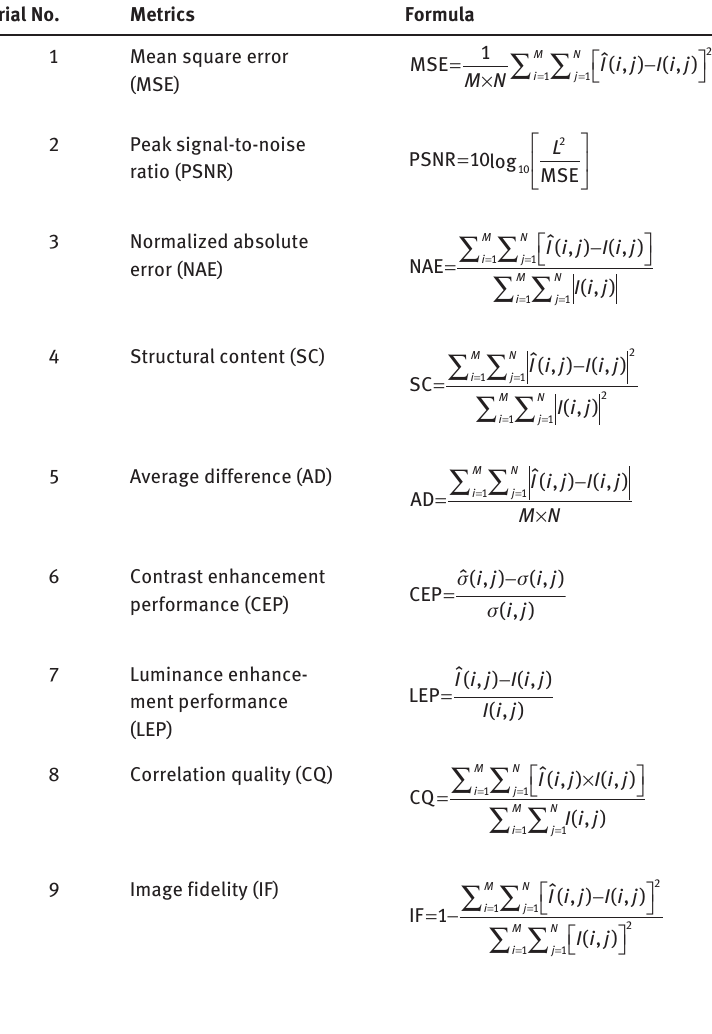
the image enhancement algorithms are listed in Table 1. I ( i , j ) and ˆ( , ) I i j denote the pixel values of the original and enhanced images, respectively. These metrics offer closeness between the two digital images by exploiting the difference in the statisti- cal distribution of the pixel values. The two graphical measures used for assessing the quality of gray or color images are histogram and Hosaka plots. However, the graphical measures fail to produce satisfactory results for color images. Table 1. Image Quality Measures. Serial